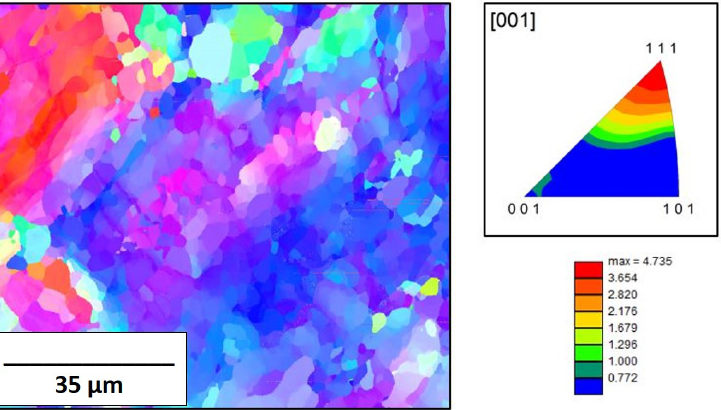
Figure 2. EBSD inverse pole figure (IPF) map for traditionally manufactured molybdenum with determined texture intensity.